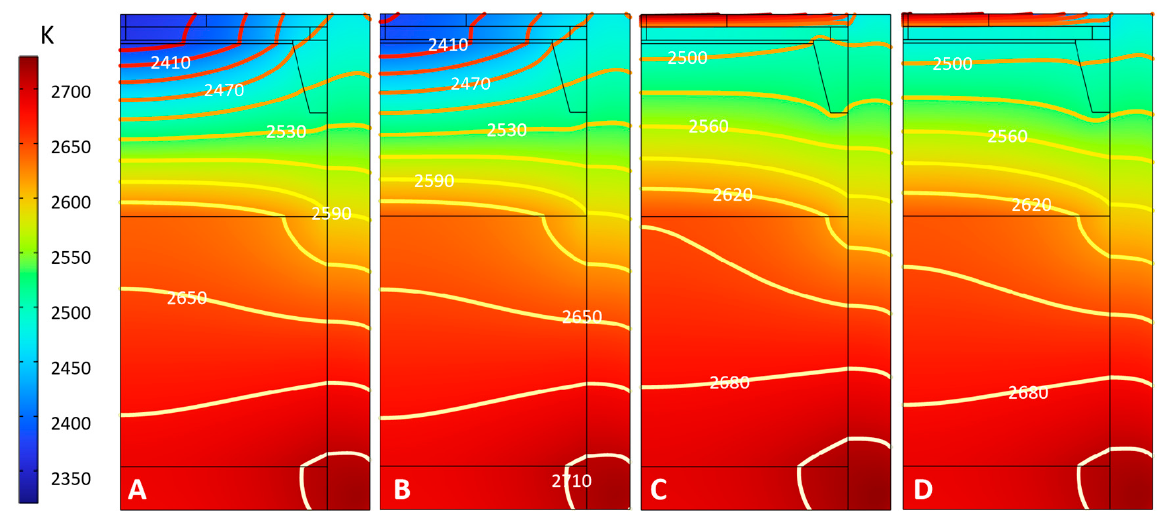
Figure 3. Temperature distribution in the crucible. ( A ) Scheme A; ( B ) Scheme B; ( C ) Scheme C; ( D ) Scheme D. ( D ) Scheme